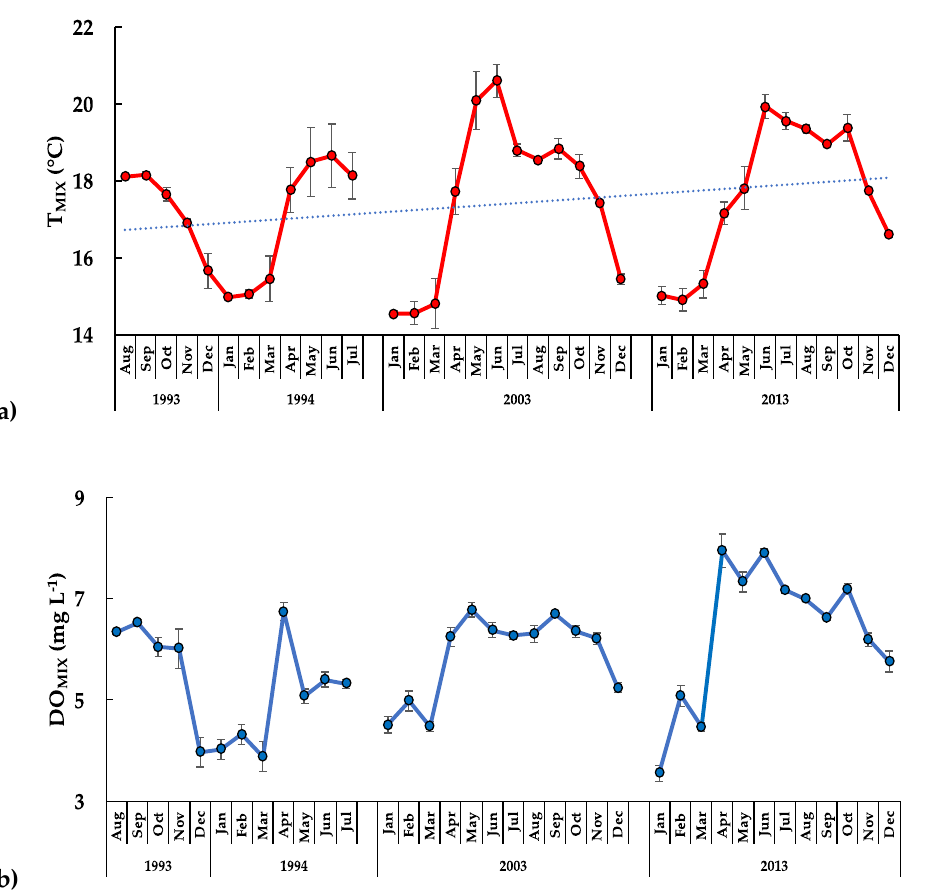
Figure 7. Temporal dynamics of the mixing zone ( a ) temperature (T MIX ) and ( b ) dissolved oxygen (DO MIX ) in Lake Alchichica. (Please note, the 1993–1994 cycle begins in August, while 2003 and 2013 in January).